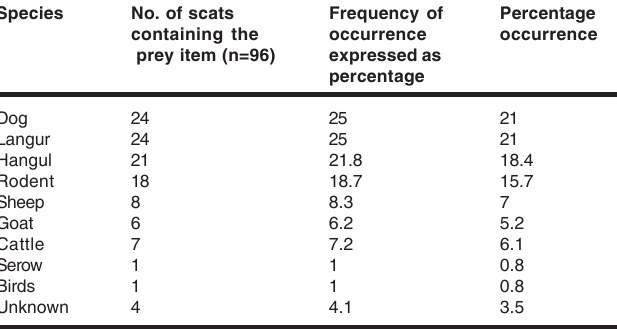
Table 1. Prey of the Leopard Panthera pardus in Dachigam National Park Species No. of scats